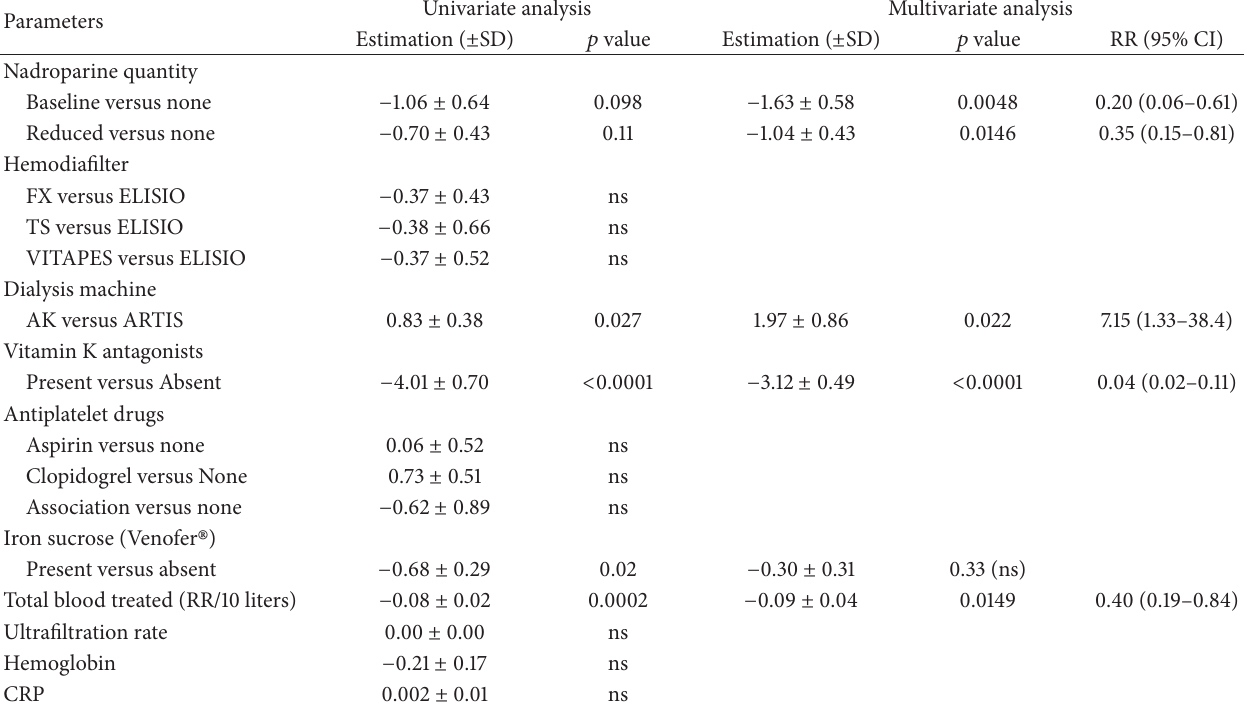
Table 3: Association of dialysis circuit coagulation with treatment